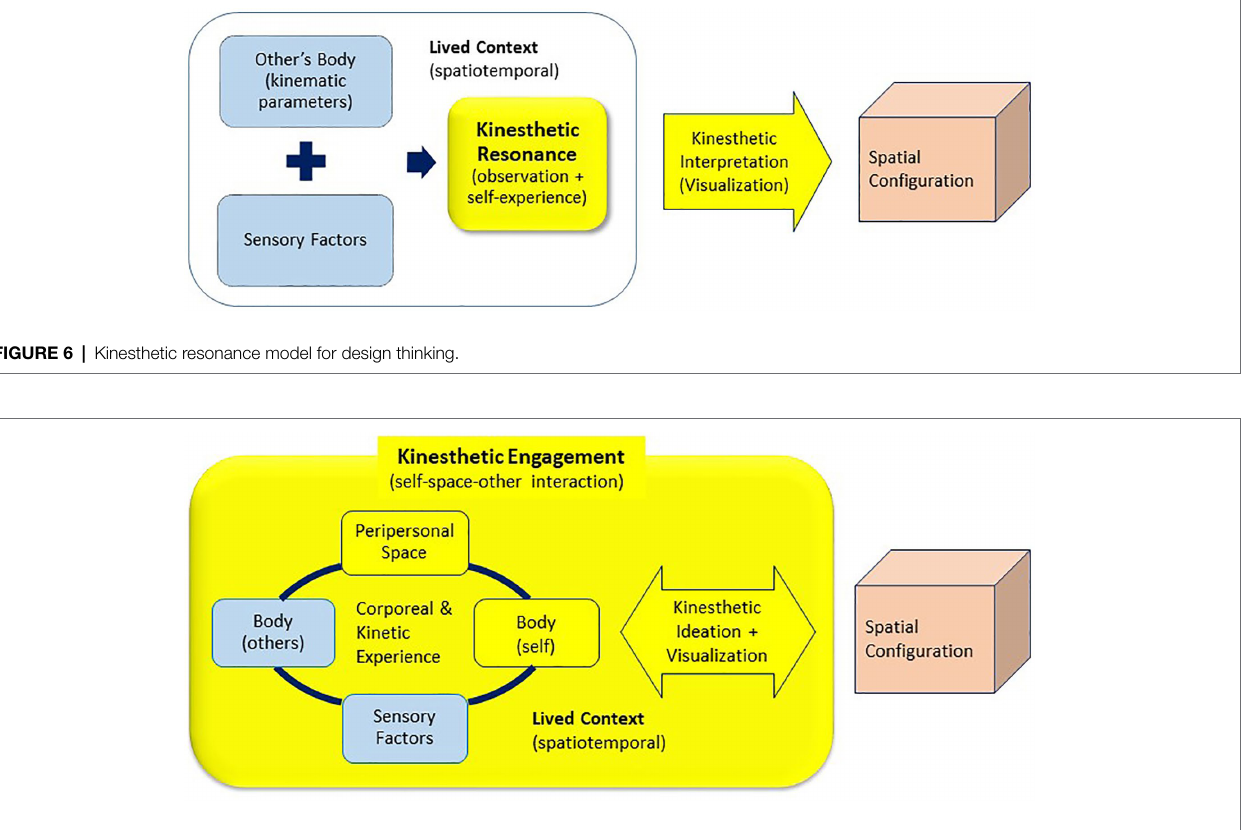
FIGURE 7 | Kinesthetic engagement model for design